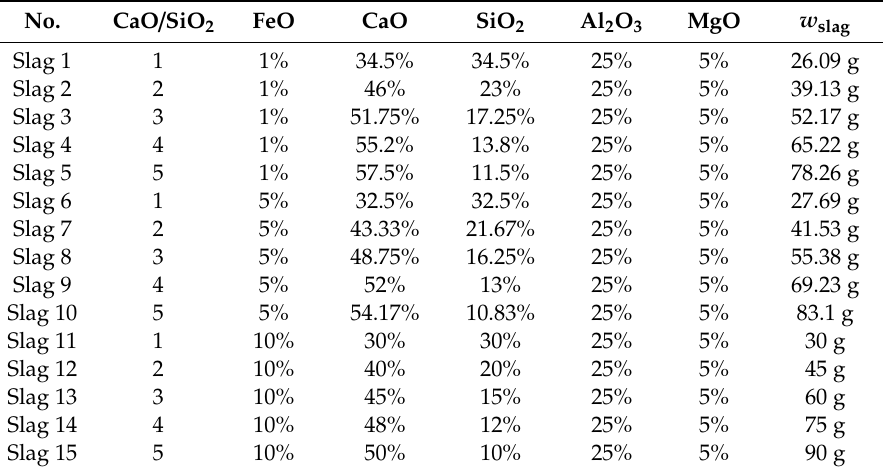
Table 3. The composition of slag used for